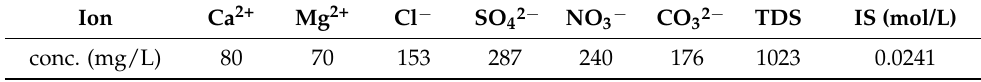
Table 2. Composition of synthetic plant water (SPW1)